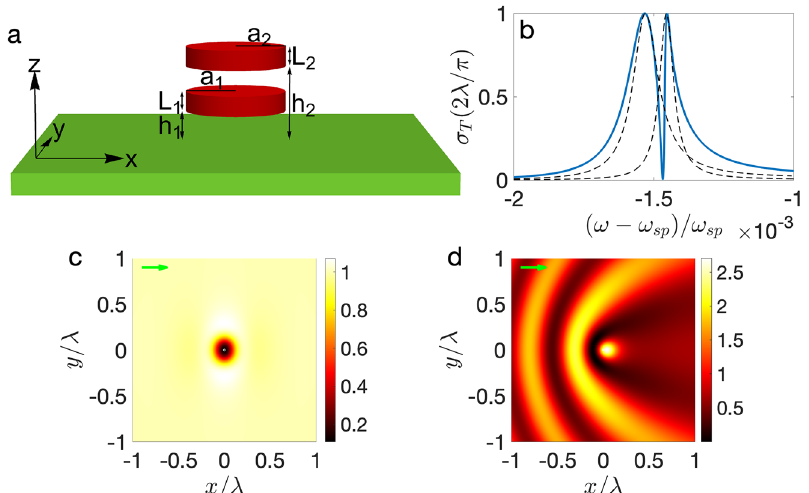
atoms are more than a wavelength apart, the fi eld ampli- tude at the focus increases almost linearly with N (intensity increases quadratically). Figure 5b and d show the band- width of the mirror and plot the maximum scattered fi eld amplitude (normalized) near the focus of the parabola as a function of frequency (solid red curve). The dotted black curves correspond to the scattering coef fi cient for the in- dividual atoms. For small N (Figure 5b), the separation between the atoms is large and the net interaction resulting from the multiple scattering between the atoms, is rela- tively weak resulting in a Lorentzian spectrum for the mirror which is quite similar to the scattering spectrum for